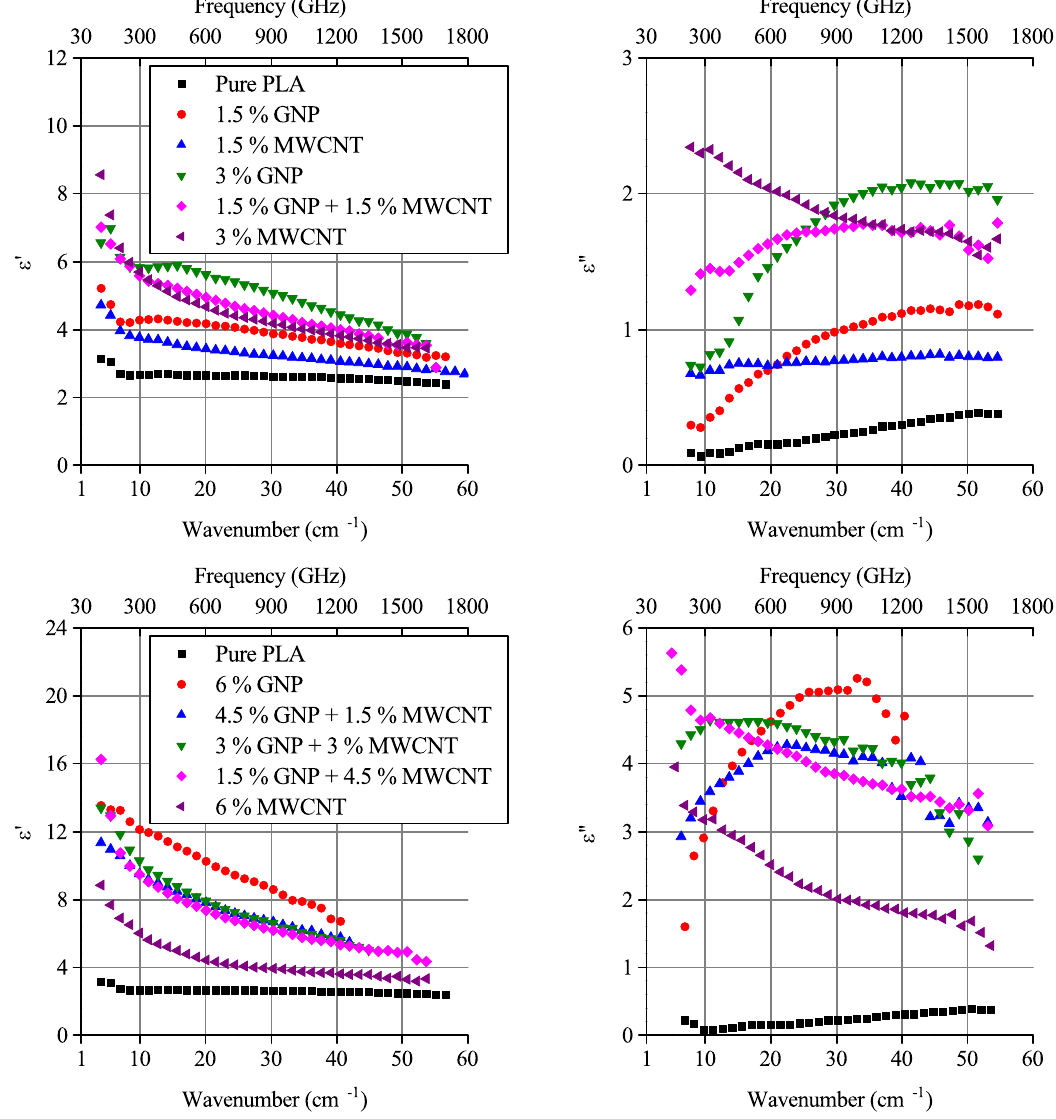
Figure 3. Complex permittivity of composites containing 3 ( top ) and 6 ( bottom ) wt.% nanocarbon fillers. MWCNT concentrations are above the percolation